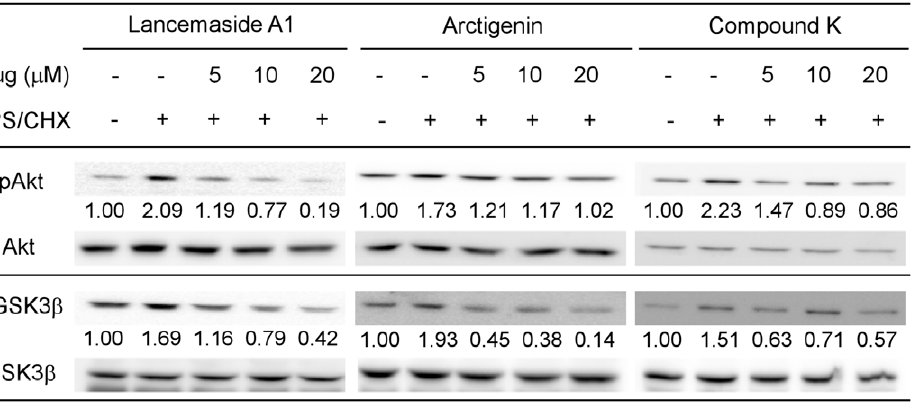
Figure 3. Examining the effects of the screened compounds on phosphorylation of Akt and GSK3 b . Western blot analysis was performed on Tat-expressing CHME5 cell lysates treated with and without LPS/CHX in the presence of the three different drug compounds at 5, 10, and 20 m M concentrations for 90 minutes. Blots were probed for antibodies against phospho-Akt (pAkt), total Akt (Akt), phospho-GSK3 b (pGSK3 b ), total GSK3 b (GSK3 b ) and b -actin. The changes in amount of pAkt and pGSK3 b levels were determined, and the mean values of the duplicates were indicated below each blot. The control lane, no LPS/CHX and drug, were set to 1. Data are representative of two independent experiments.